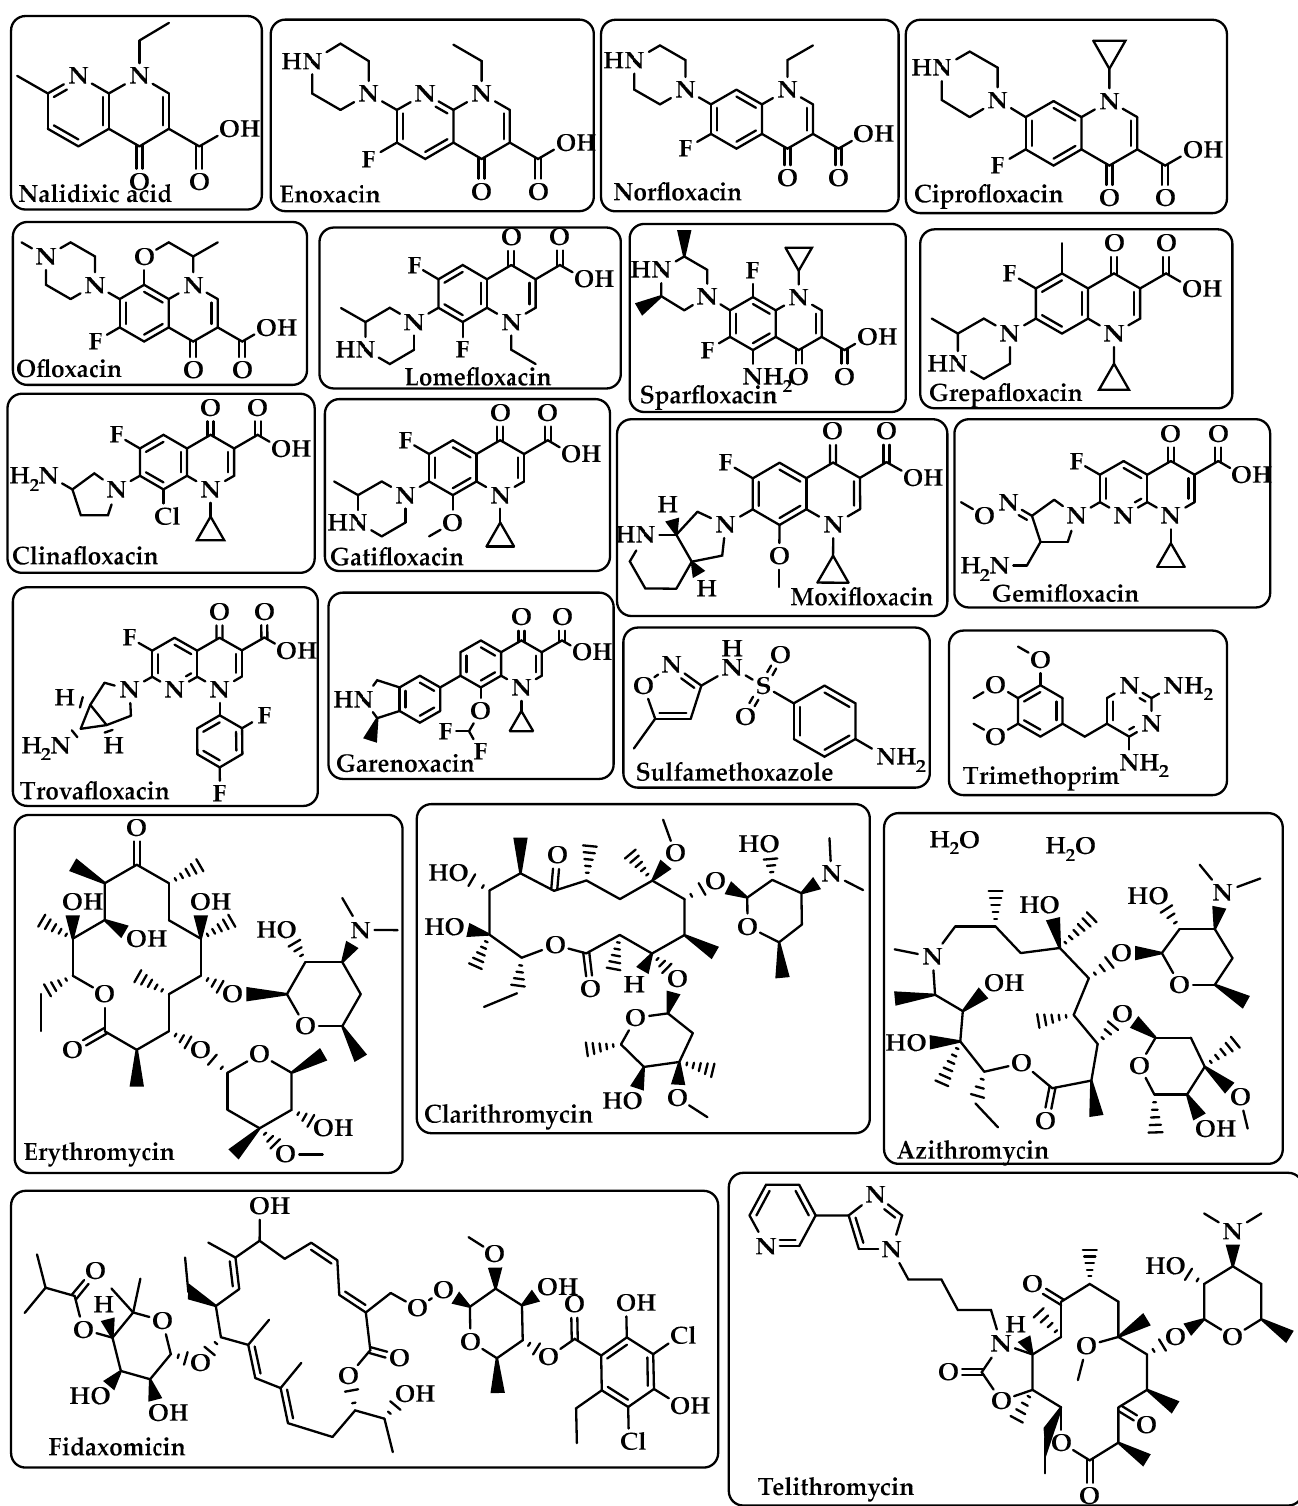
Figure 4. Chemical structure of nalidixic acid, enoxacin, nor fl oxacin, cipro fl oxacin, o fl oxacin, lome fl oxacin, spar fl oxacin, grepa fl oxacin, clina fl oxacin, gati fl oxacin, moxi fl oxacin, gemi fl oxacin, trova fl oxacin, arenoxacin, sulfamethoxazole, trimethoprim, erythromycin, clarithromycin, azithromycin, fi daxomicin, and telithromycin.